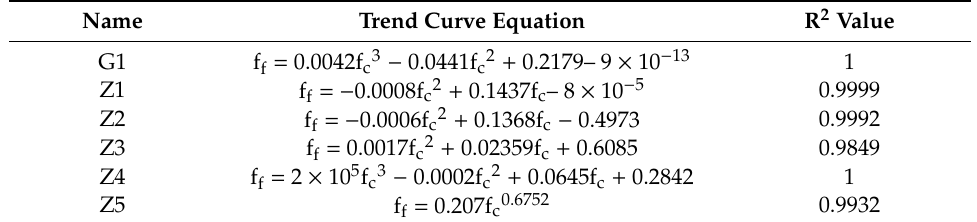
Figure 9. Flexural strength to compressive strength ratio trend curves. Table 11. Comparison of flexural strength and compressive strength ratio trend curves and coe ffi cient of